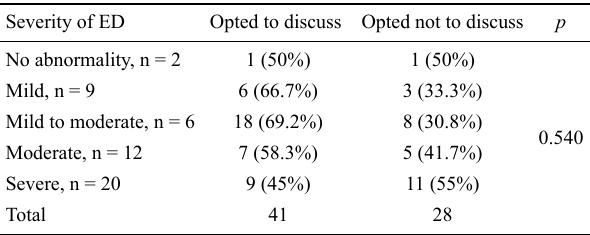
Table 3b. Association of severity of ED and option of wanting to discuss or not about their sexual dysfunction (intervention